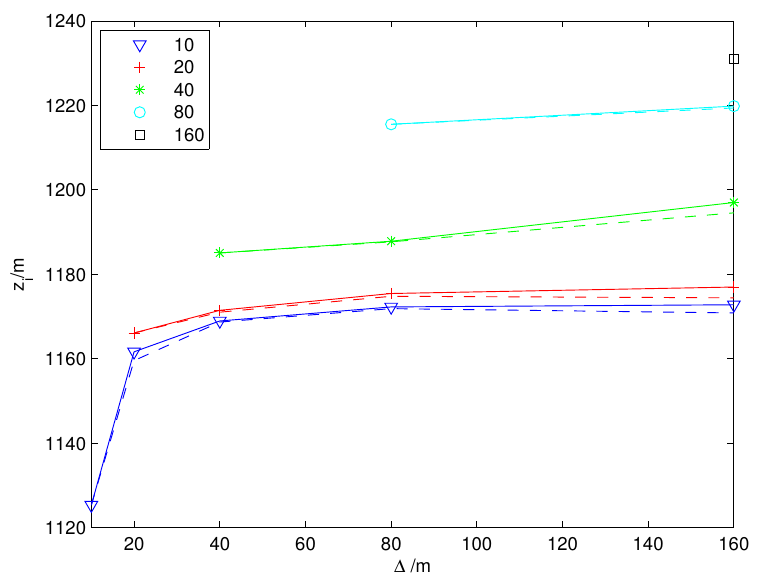
Figure 3. Boundary layer height diagnosed from each CBL1 simulation plotted at its native grid length and also when computed after coarse graining of the data onto other grids. The solid lines indicate coarse graining in all three directions, whereas the dashed lines are for coarse graining in the horizontal